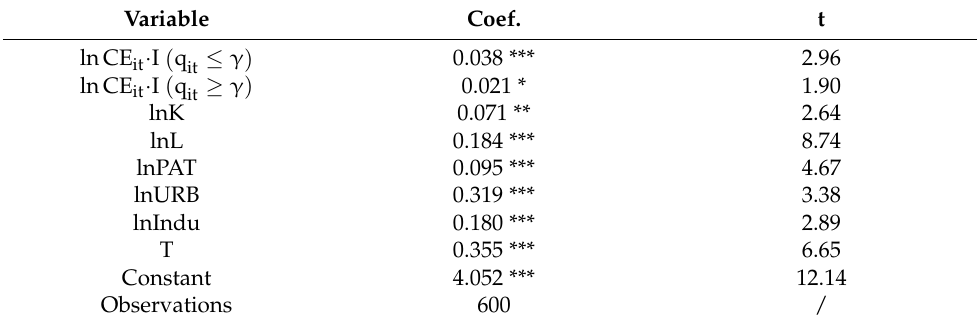
Table 4. Estimation results of the panel threshold